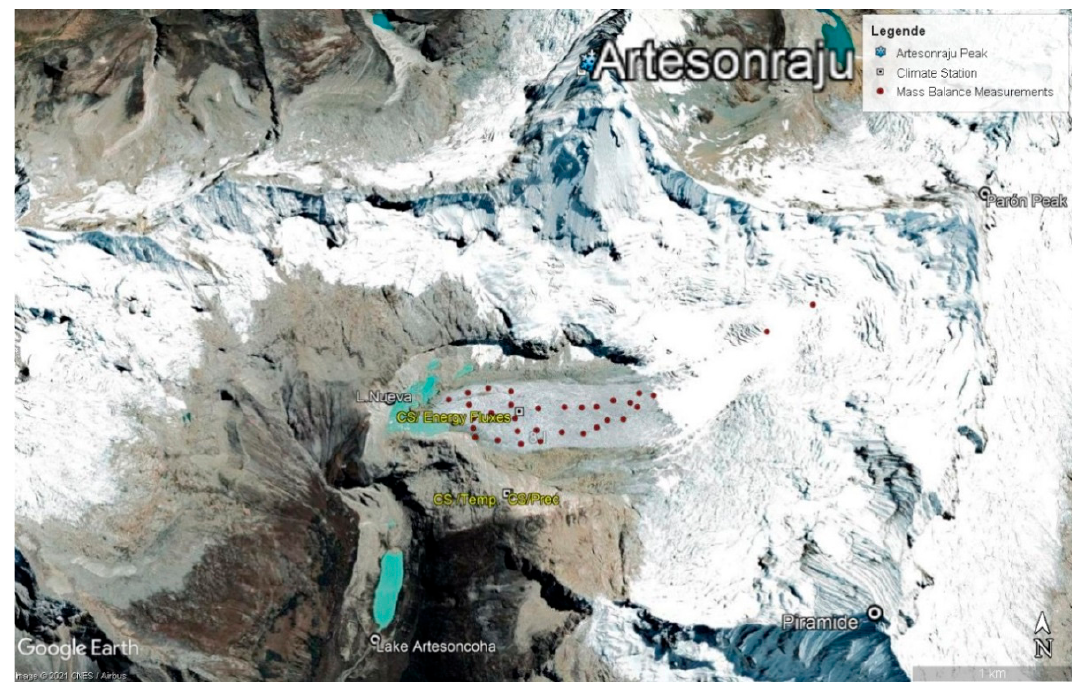
Figure 2. Locations of climate station (CS) used in the study. Satellite image of Artesonraju glacier taken from Google Earth 2019.